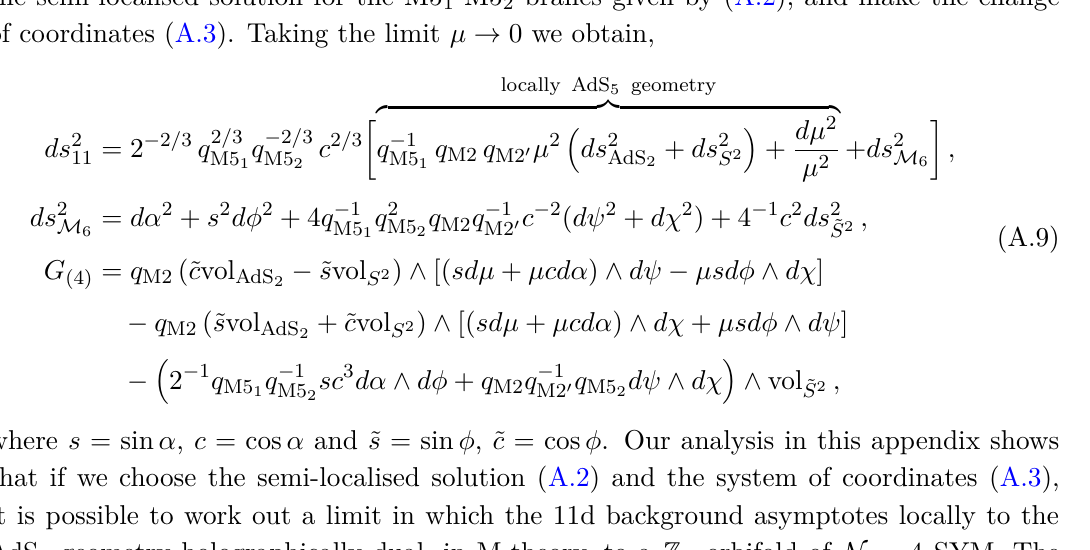
× S 2 geometries curving the worldvolume of the 2